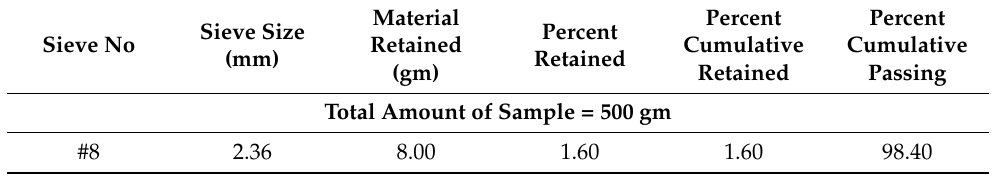
Table 1. Sieve analysis of fine